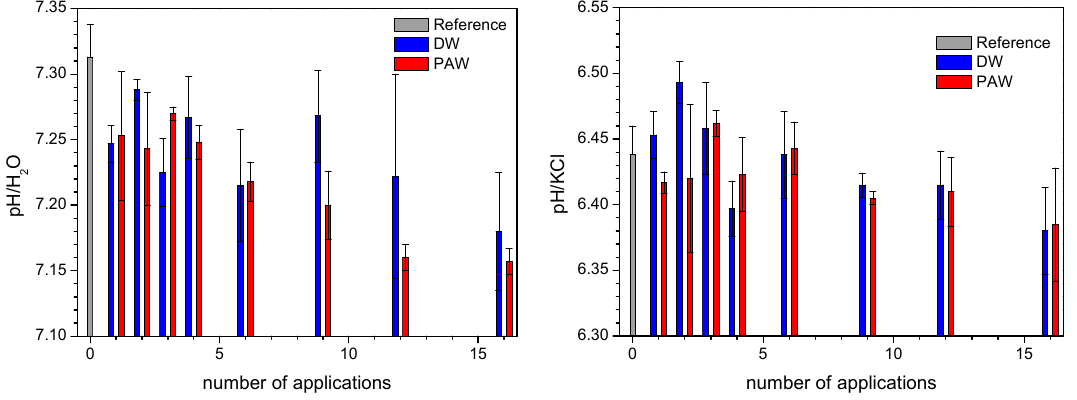
Figure 9. Soil pH values at the selected number of DW and PAW applications.